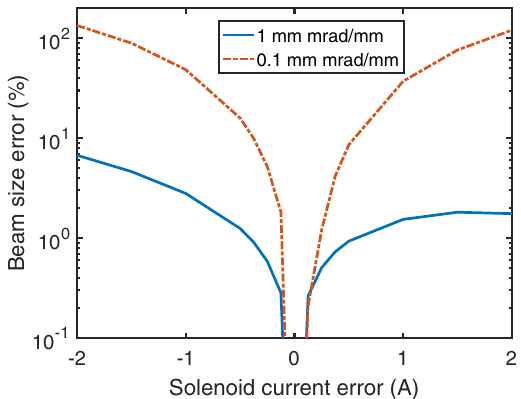
FIG. 7. The beam size error caused by the solenoid current error with respect to the momentum imaging condition.